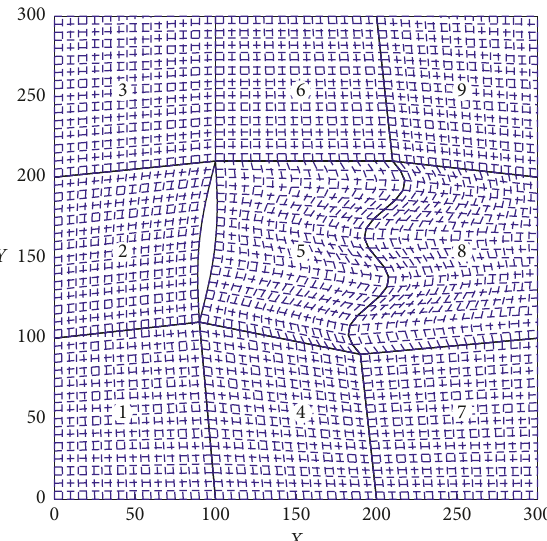
Figure 10: Illustrative model containing curve cracks.